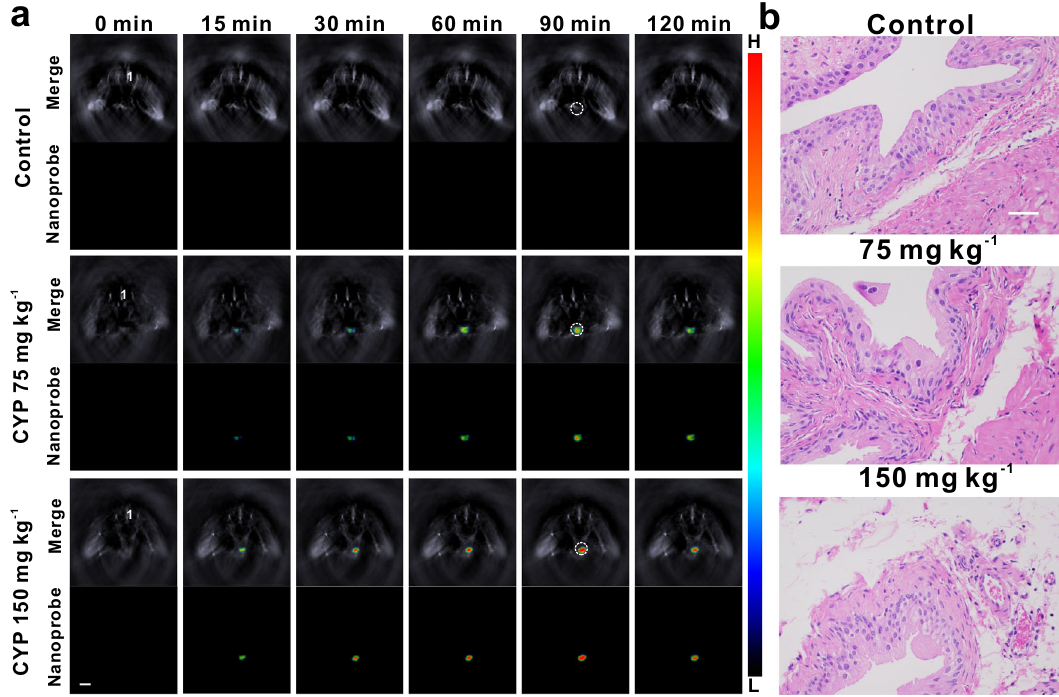
Fig. 4 Application of nanoprobe BTPE-NO 2 @F127 in interstitial cystitis mouse model via MSOT imaging and H&E analysis. a Representative cross- sectional MSOT images of the control mice (the healthy mice intraperitoneally injected with saline) and the interstitial cystitis model groups (24 h after intraperitoneal injection with 75 mg kg − 1 CYP or 150 mg kg − 1 CYP) at various time points post intravesical injection of BTPE-NO 2 @F127. The mice were in prone position. Upper panel: overlay of the activated probe signal with the background (grayscale) signal. Lower panel: multispectrally resolved signal from the activated probe. Organ labeling: 1 artery. White dotted circle: bladder region. Color bar: L: 6.1 × 10 1 , H: 4.1 × 10 3 (arb. units). b Tissue sections (H&E staining) for bladders of various mice groups ( n = 5 animals per group. The experiments were repeated independently three times with similar results). Scale bar: 50 μ m. CYP